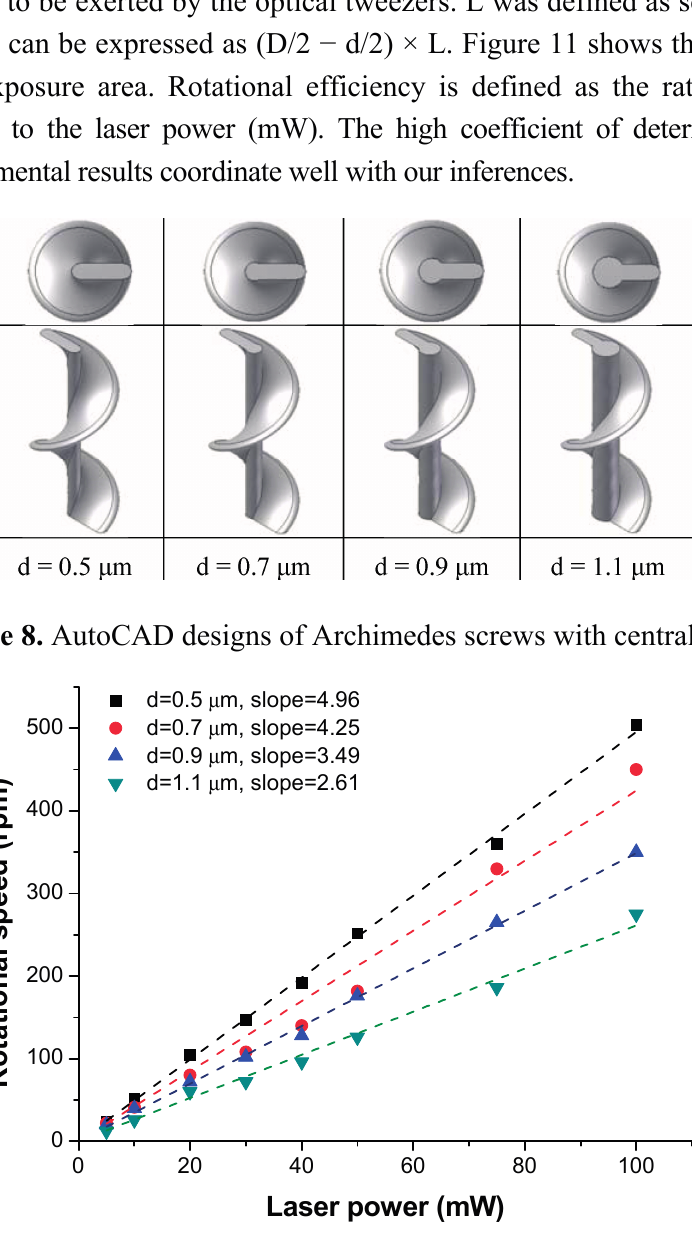
Figure 9. The evolution of rotational speeds under increasing laser power for micro-crews with different rod diameters ( d = 0.5 μ m, 0.7 μ m, 0.9 μ m, and 1.1 μ m).